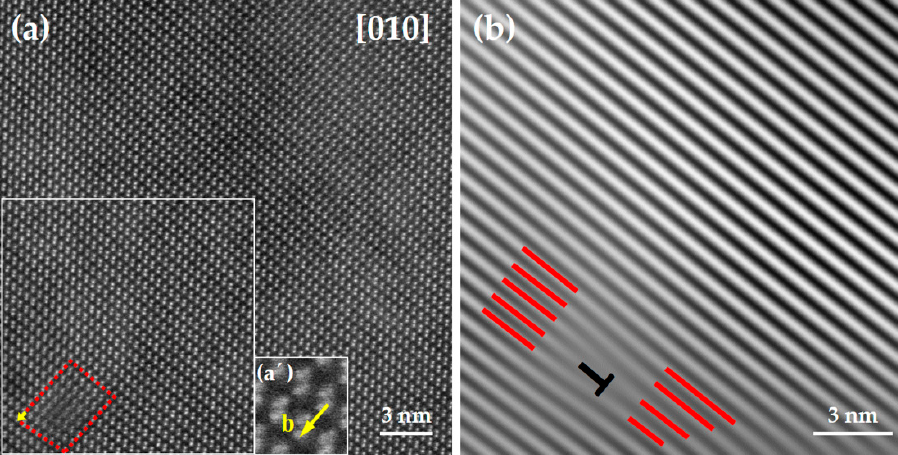
Figure 6. ( a ) The STEM-HAADF image of the monazite (the same FIB foil with that in Figure 5c) with some distrored lattices existed. The lattice distortions were encircled by Burgers circuit (red dashed line). The inset ( a´ ) illustrated the enlarged Burgers vector that was marked with a yellow arrow in the Burgers circuit (the ruler in a´ was overlooked). ( b ) Inverse fast Fourier transform image of the area given by the box. The edge dislocations marked with the black ┴ sign are clearly visible.